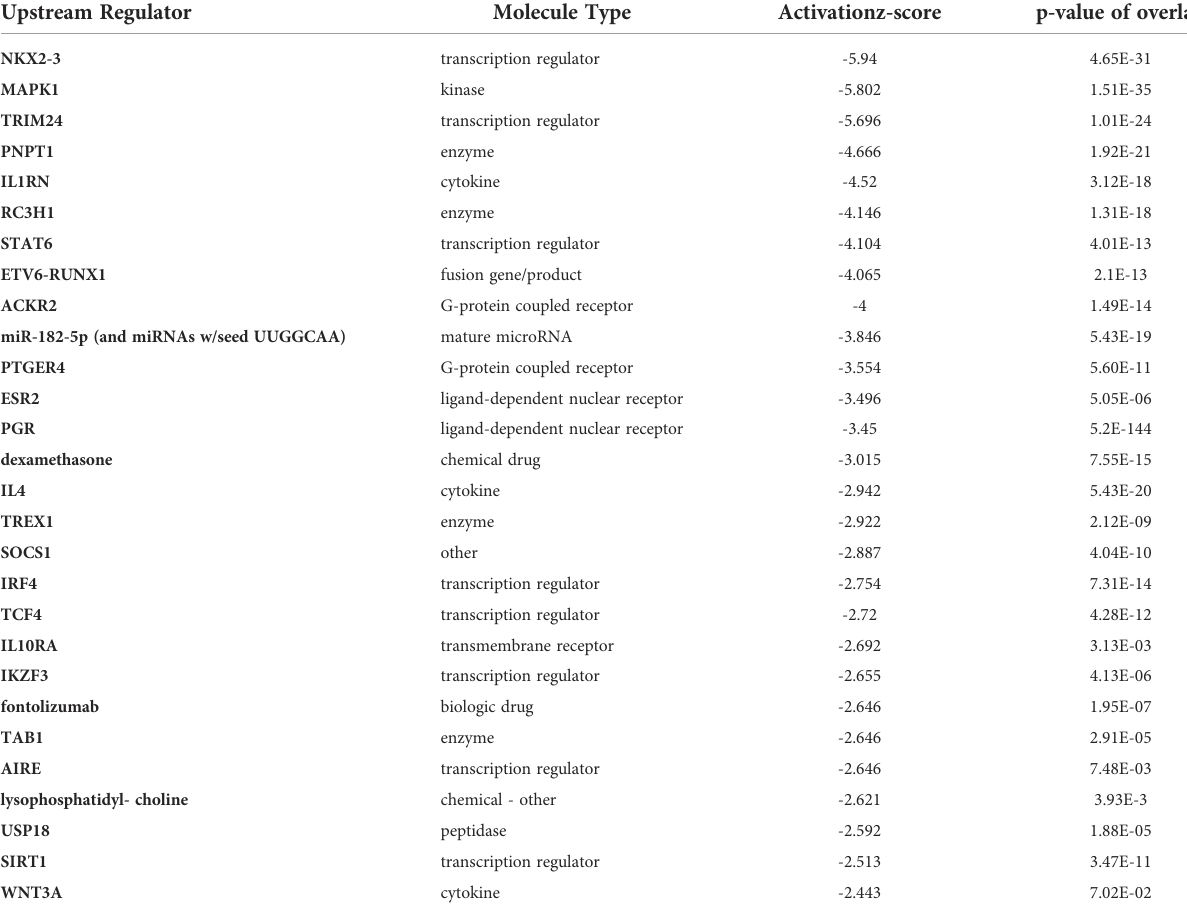
TABLE 4 Upstream regulators with Negative